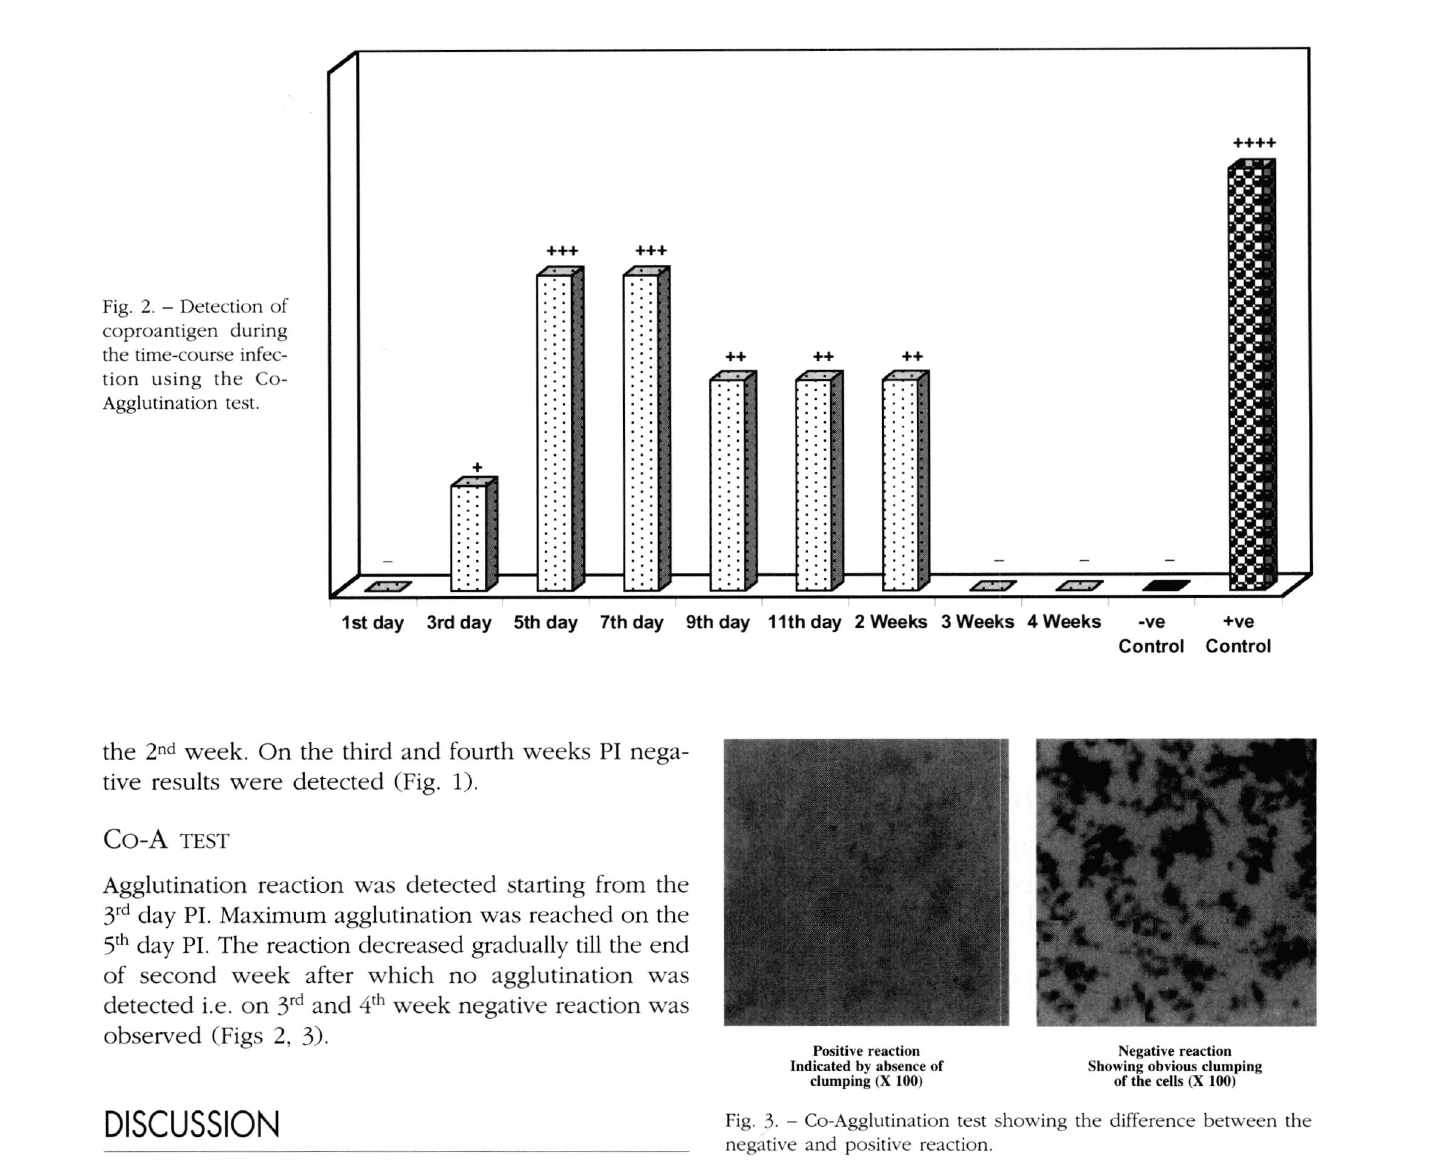
Fig. 3. – Co-Agglutination test showing the difference between the negative and positive